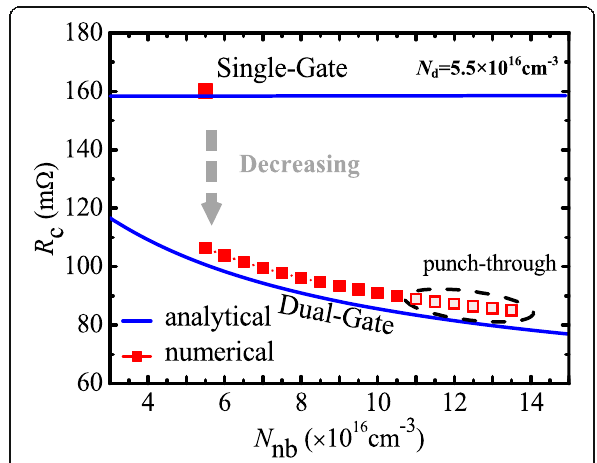
Fig. 2 Numerical and analytical R c as a function of N nb with single- gate and dual-gate ( Z = 1 cm). N d is the doping concentration of the N-drift region